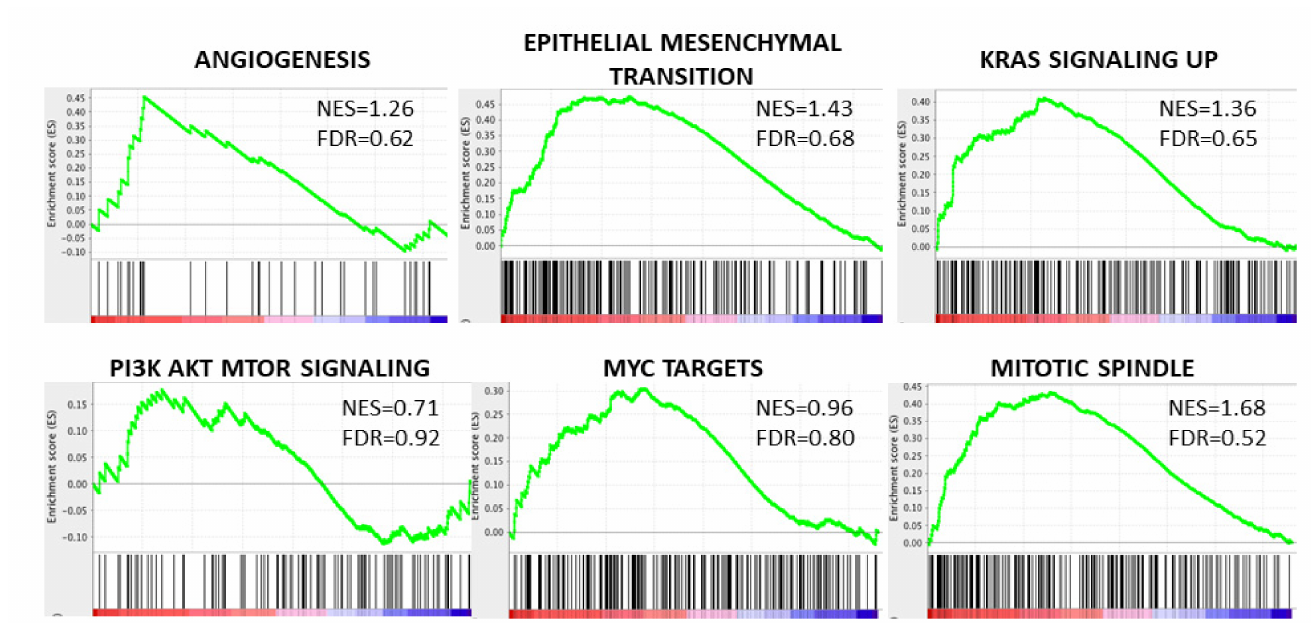
Figure 4. Gene Set Enrichment Analysis (GSEA) of the octogenarian group with Normalized Enrichment Score (NES) and False Discovery Rate (FDR). Representative gene sets associated with cancer malignancy in GSEA analysis (TCGA